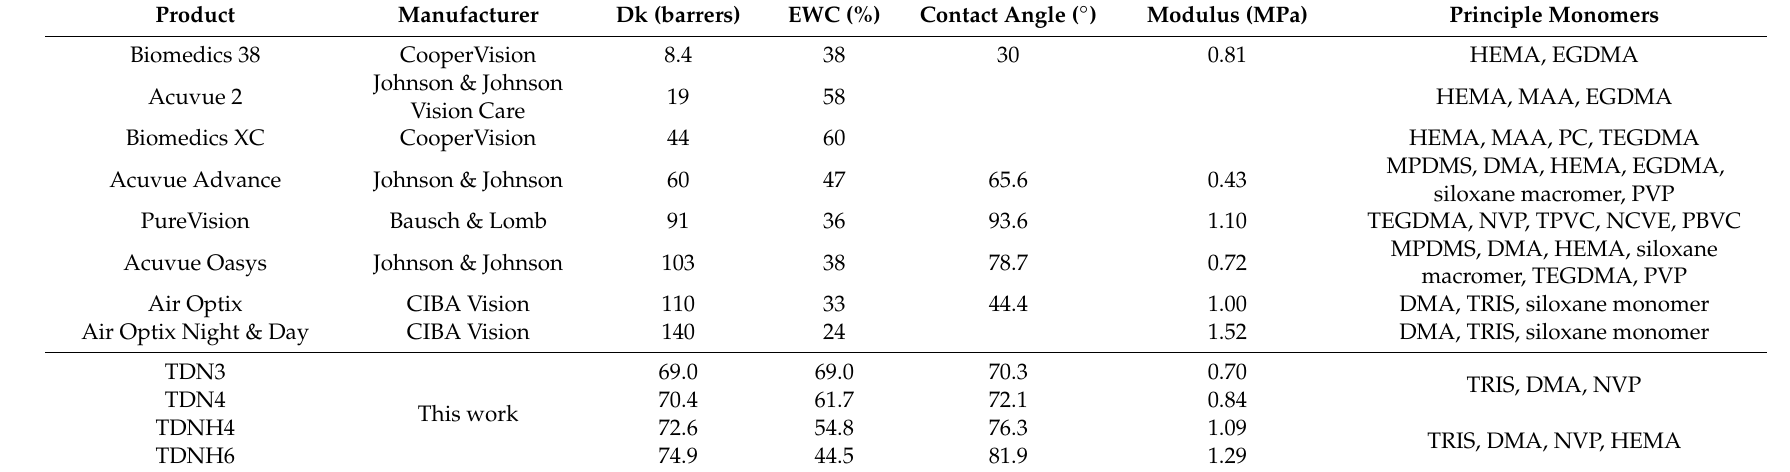
Table 2. Properties comparison of commercial lenses and this